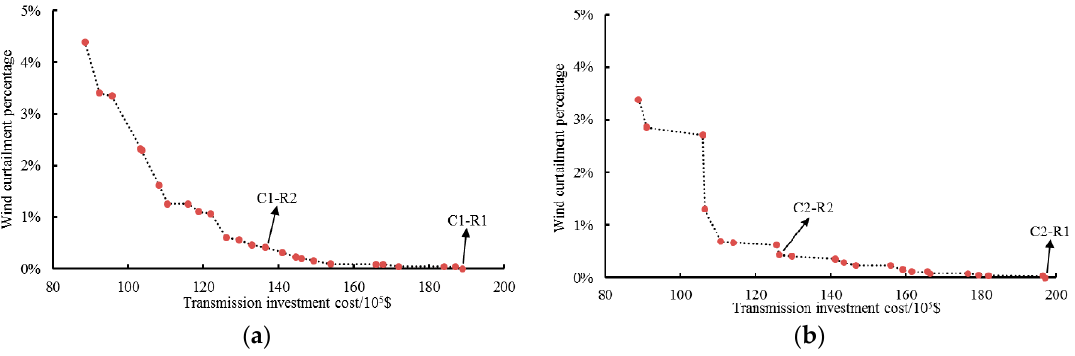
Figure 8. ( a ) Feasible planning schemes of C1; ( b ) Feasible planning schemes of C2.